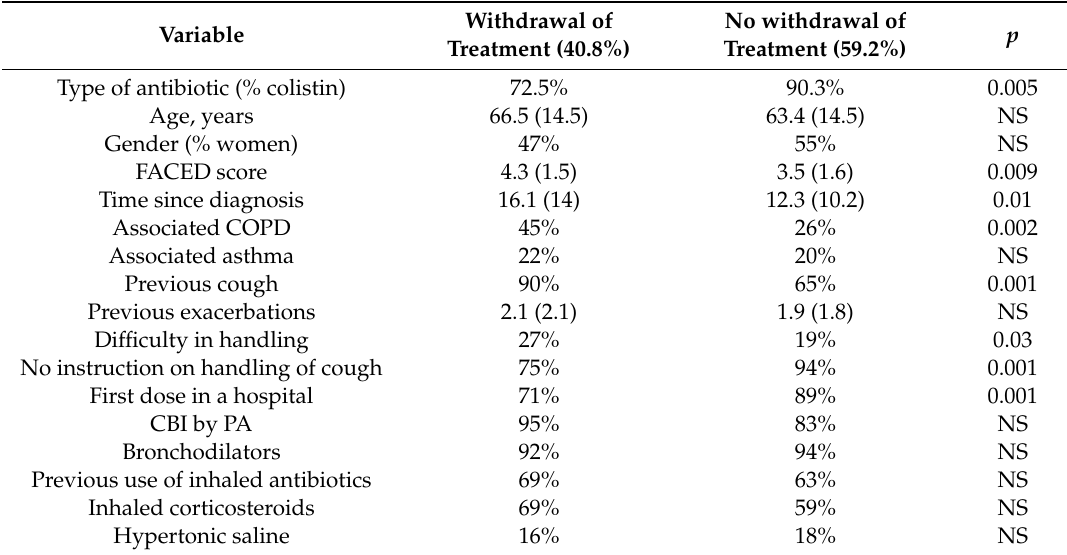
Table 7. Withdrawal of treatment with dry powder antibiotics.